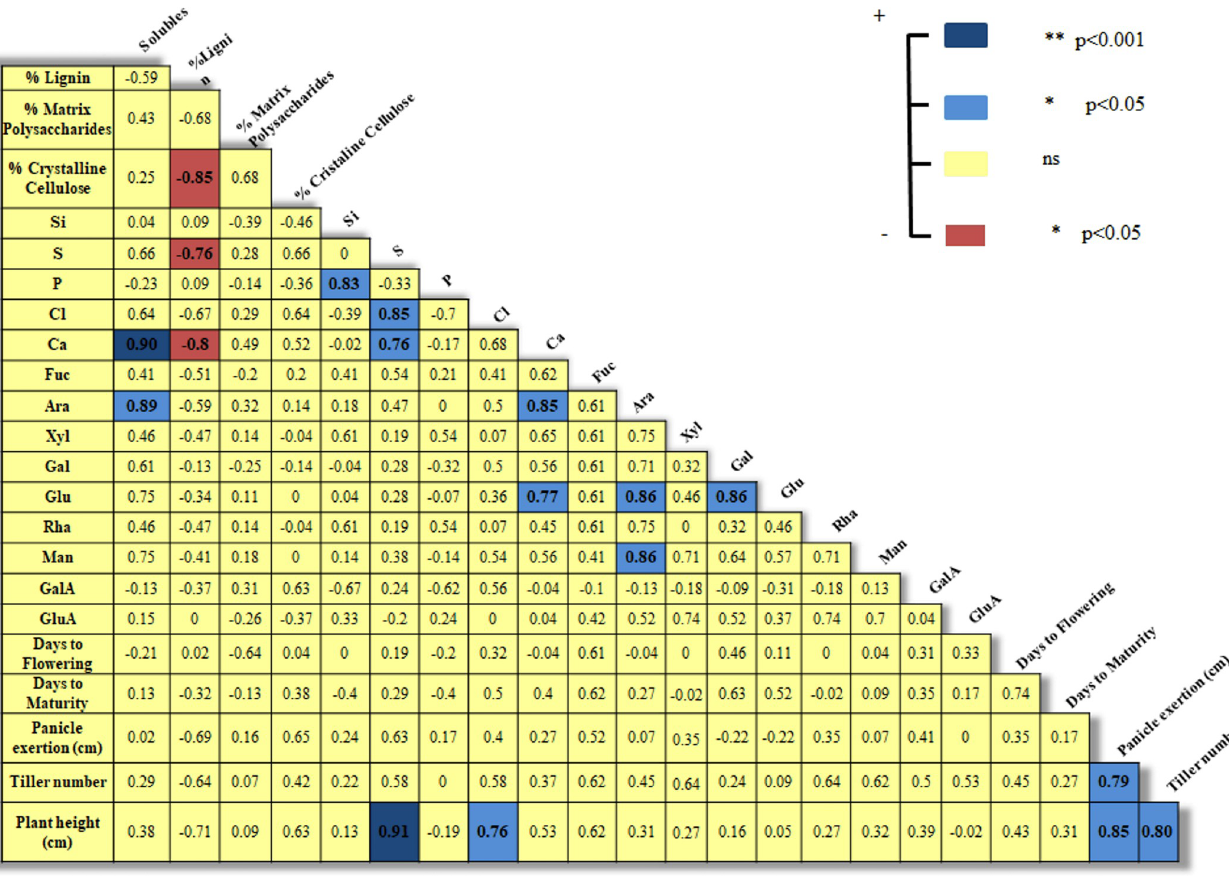
Fig 6. Spearman´s correlation coefficients among phenological traits, major polymers, monosaccharides, and elements in stem cell walls of sudangrass accessions.